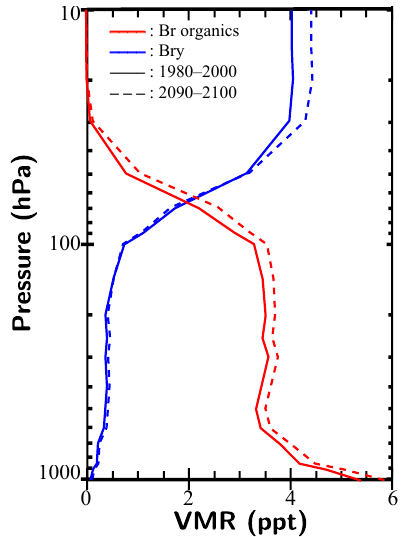
Figure 4. Tropical zonal mean (20 ◦ N–20 ◦ S), temporally averaged, vertical profiles of organic (Br org ) and inorganic bromine (Br y ) for the time periods 1990–2000 and 2090–2100 from SC_free. In con- sistency with increasing VSLS fluxes by 10% in the tropics, an in- crease of roughly 10% in Br y from VSLS in the stratosphere is found, while the increase in Br org amounts to